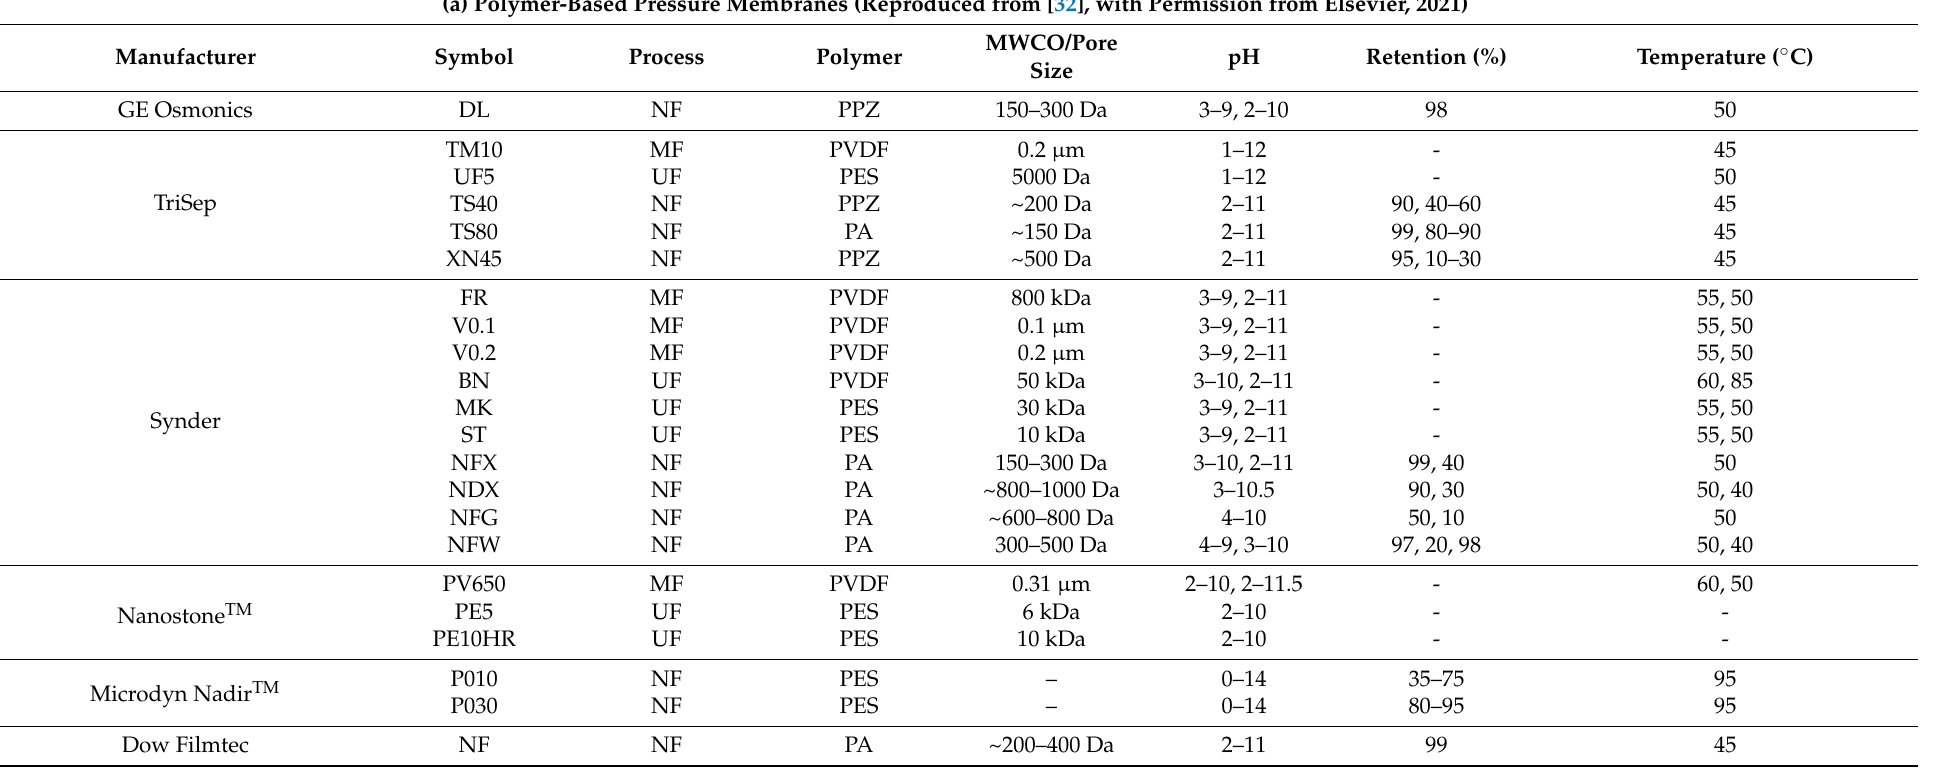
Table 1. Overview of commercial membranes used in the dairy